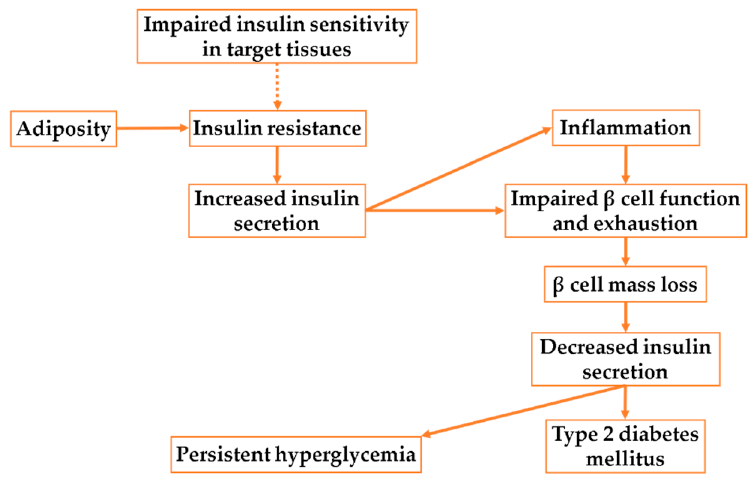
Figure 3. Schematic diagram of insulin resistance and the physiological and pathological conse- quences.